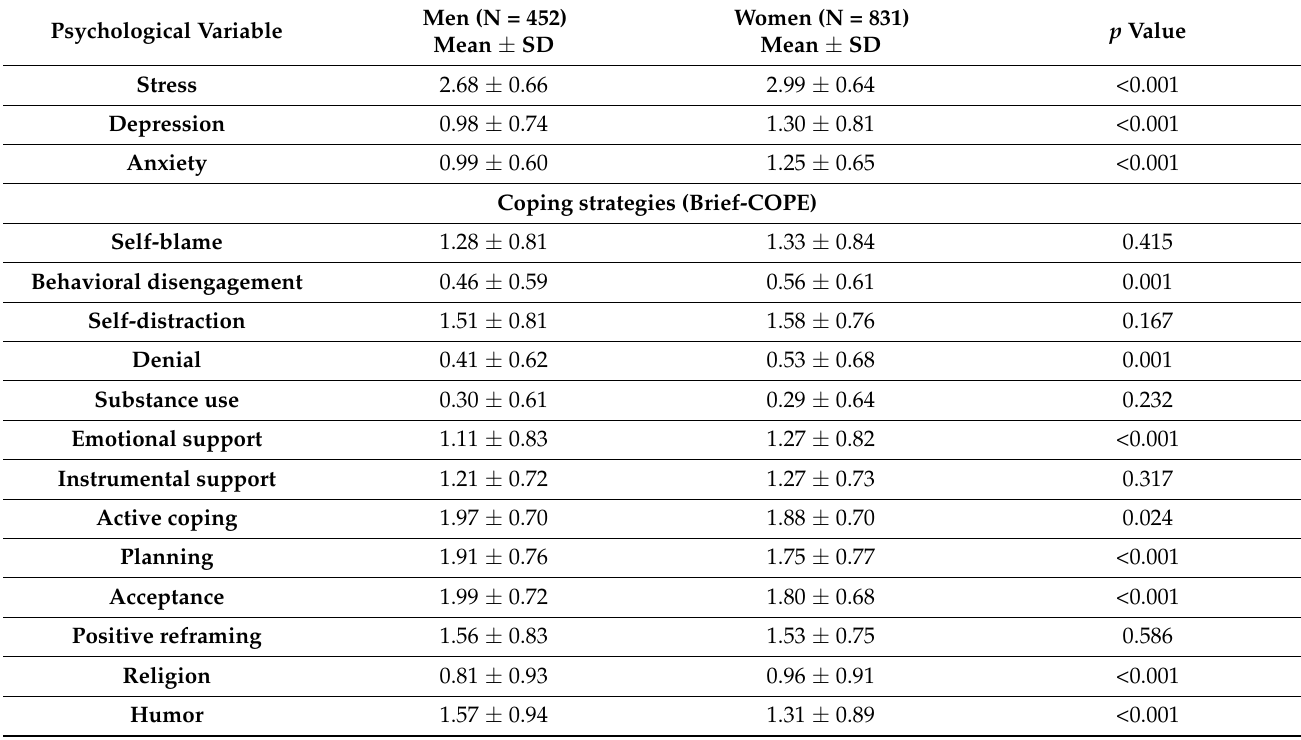
Table 2. Comparison of psychological variables and coping strategies between